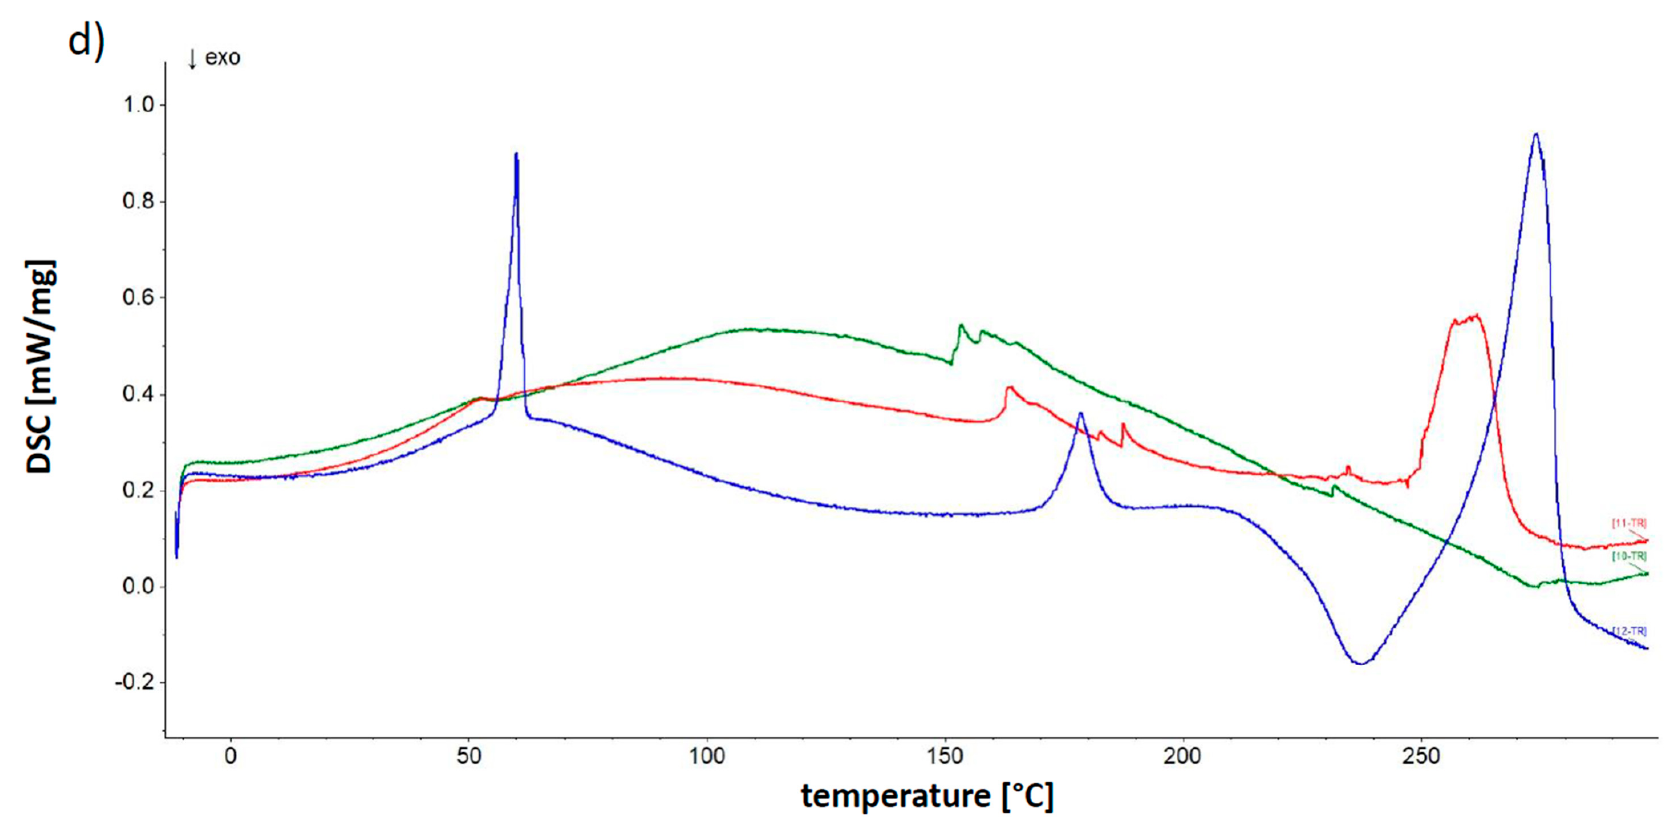
Figure 7. The DSC thermograms of ( a ) F2 (green line), F7 (red line) and physical mixture of F7 (blue line); ( b ) F3 (green line), F8 (red line) and physical mixture of F8 (blue line); ( c ) F4 (green line), F9 (red line) and physical mixture of F9 (blue line); ( d ) F5 (green line), F10 (red line) and physical mixture of F10 (blue line).